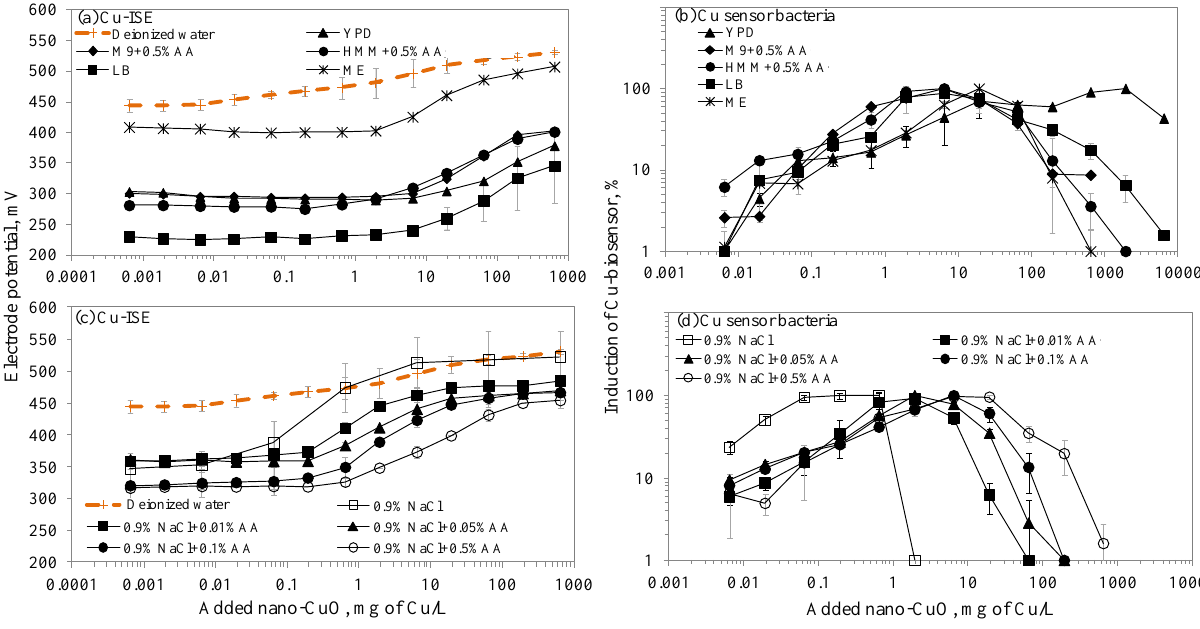
Figure 3. Response of Cu ion-selective electrode (Cu-ISE; left panels) and Pseudomonas fluorescens OS8::KnCueRPcopAlux Cu-biosensor (right panels) to nano-CuO in different ecotoxicological and microbiological media. ( a , b ) organics-containing media; ( c , d ) 0.9% NaCl with various concentrations of Cas-amino acids (AA).